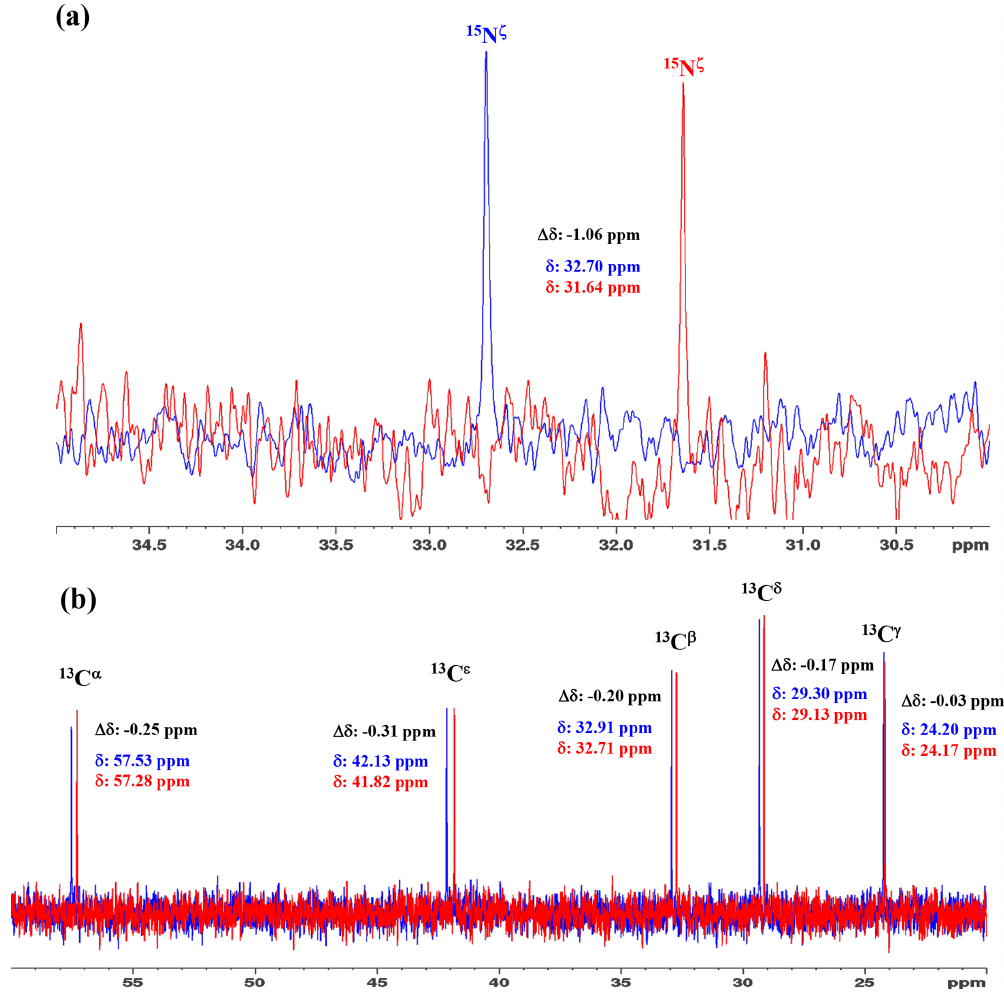
Figure 3. 1D 15 N and 13 C NMR spectra of [ 15 N 2 ]-lysine in H 2 O and D 2 O. The 96.3MHz 1D 15 N NMR spectra (a) and 239.0MHz 1D ◦ C on a Bruker Avance III 950 spectrometer with a TCI cryogenic probe, using 13 C NMR spectra (b) of [ 15 N 2 ]-lysine were measured at 30 ∼ 70mM solutions of 20mM tris buffer prepared with H 2 O (or D 2 O) at pH (or pD) 8.0. The NMR spectra and the chemical shifts, δ DSS ( 13 C / 15 N), shown in blue and red, are those for the H 2 O and D 2 O buffer solutions, respectively. The deuterium-induced shifts, (cid:49)δ DSS ppm: δ (in D 2 O) − δ (in H 2 O), for the 15 N ζ and side-chain 13 C signals are shown in